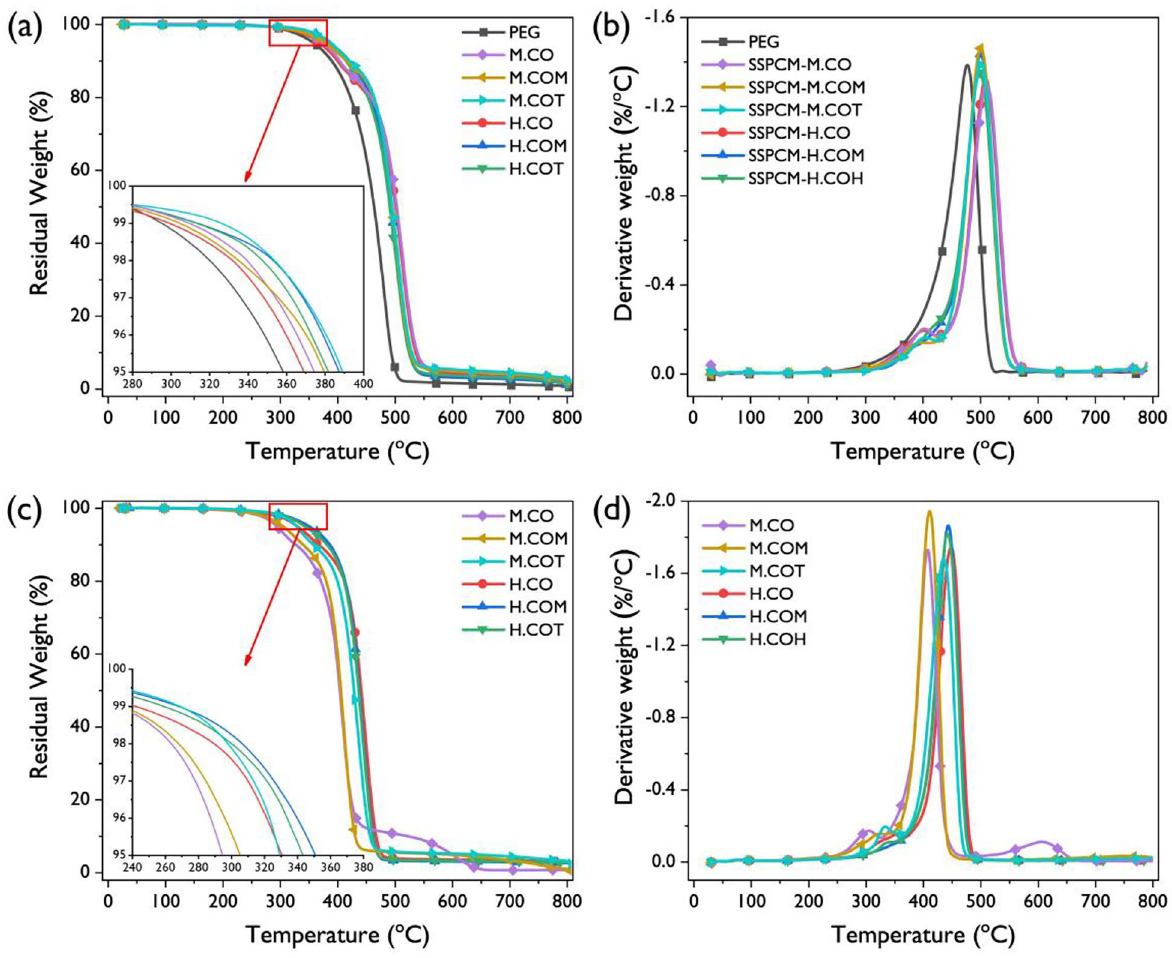
Figure 10. ( a ) TGA thermograms of the SSPCMs and ( b ) their derivates. ( c ) TGA thermograms of the SSPCMs and ( b ) their derivates before and after the accelerated thermal cycling